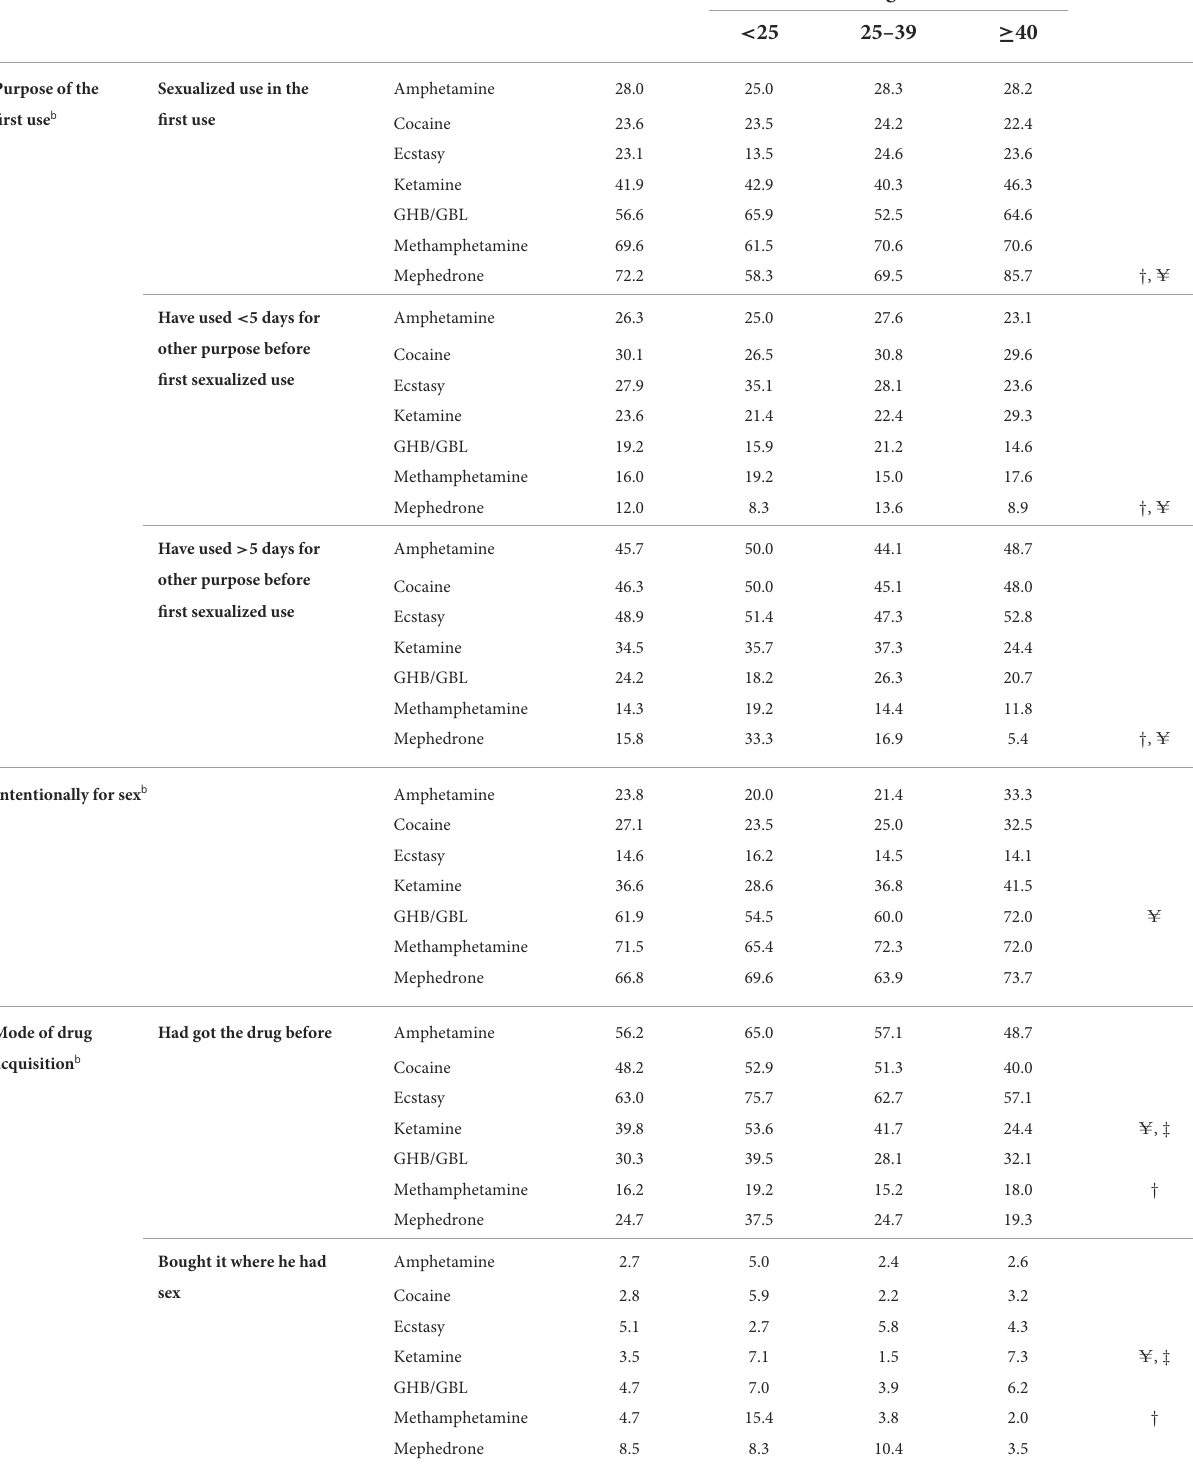
TABLE 3 Characteristics of the first episode of sexualized use for different drugs by age among MSM a from Madrid and Barcelona. All Age P -value < 25 25–39 ≥